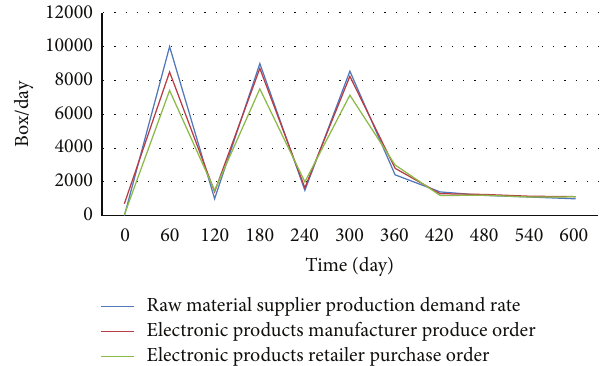
Figure 4: The environmental policy index = 1, the order demand fluctuations in various members.